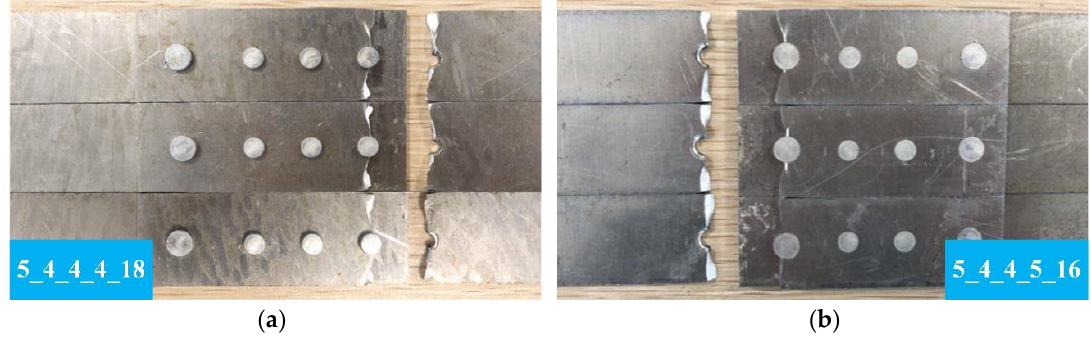
Figure 18. Typical fatigue crack morphology of specimens: ( a ) Group 5_4_4_4_18, crack site is on the upper plate near #1 rivet; ( b ) group 5_4_4_5_16, crack site is on the lower plate near #4 rivet.